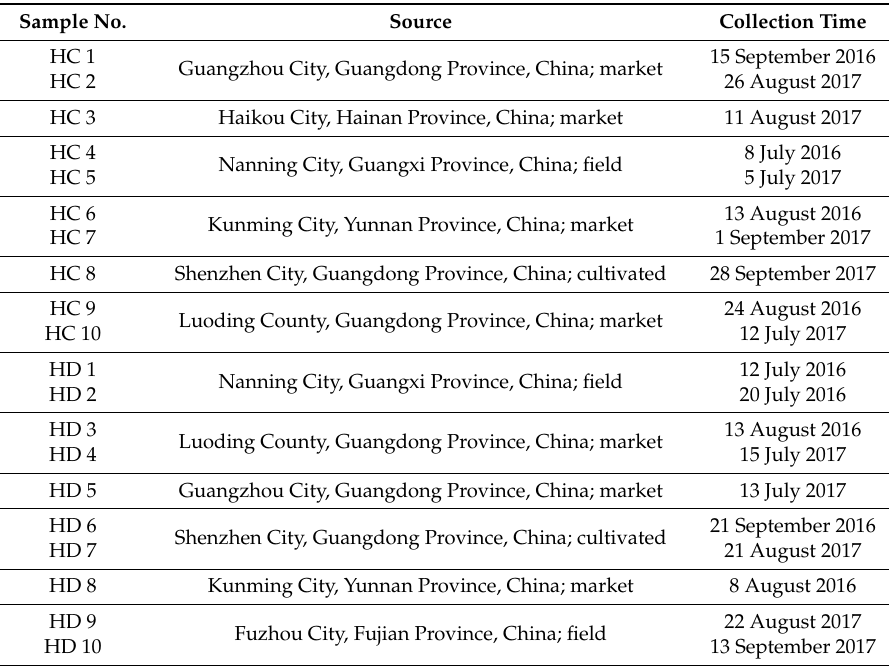
Table 1. The list of the tested samples from China. Sample